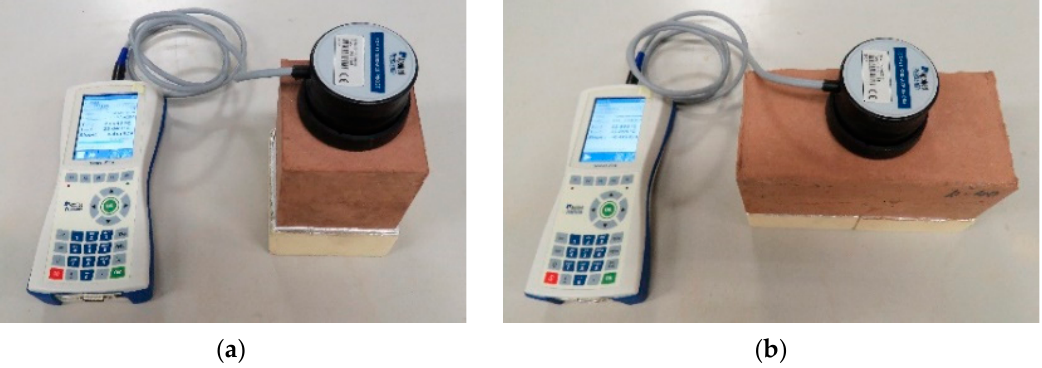
Figure 5. Thermal tests: ( a ) 100 mm × 100 mm × 100 mm sample; ( b ) 100 mm × 100 mm × 215 mm sample.